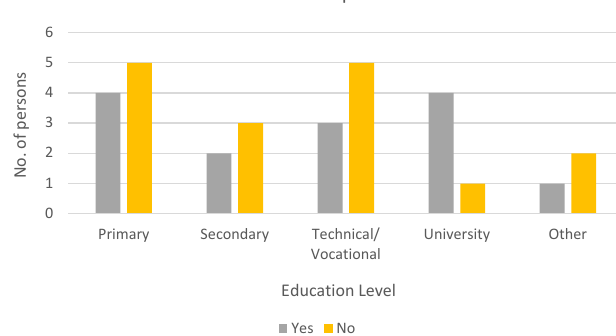
Fig. 7: Use of alternative garbage disposal options by education level